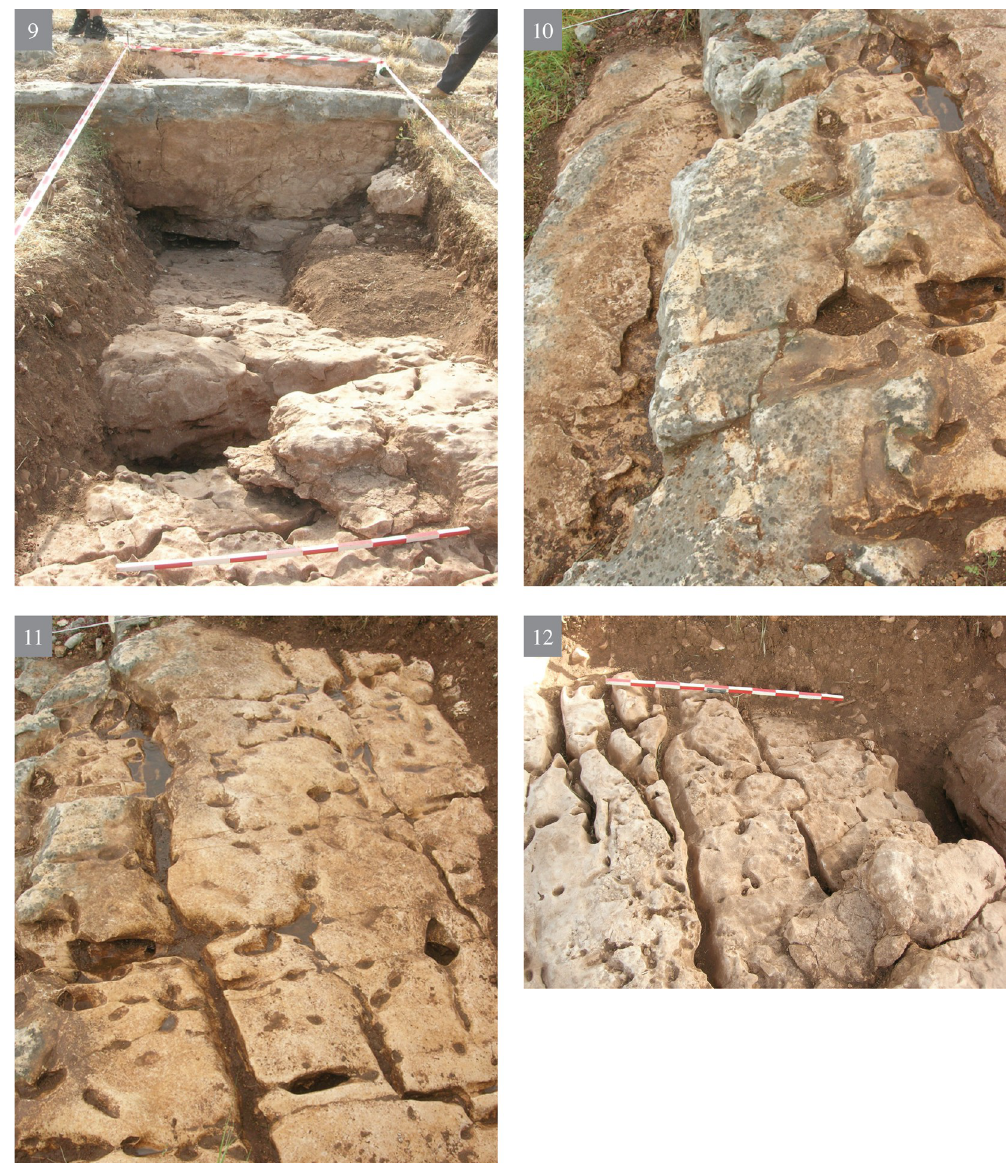
Fig 12. The excavation trench. (9–12) the quarrying fronts and the exploited